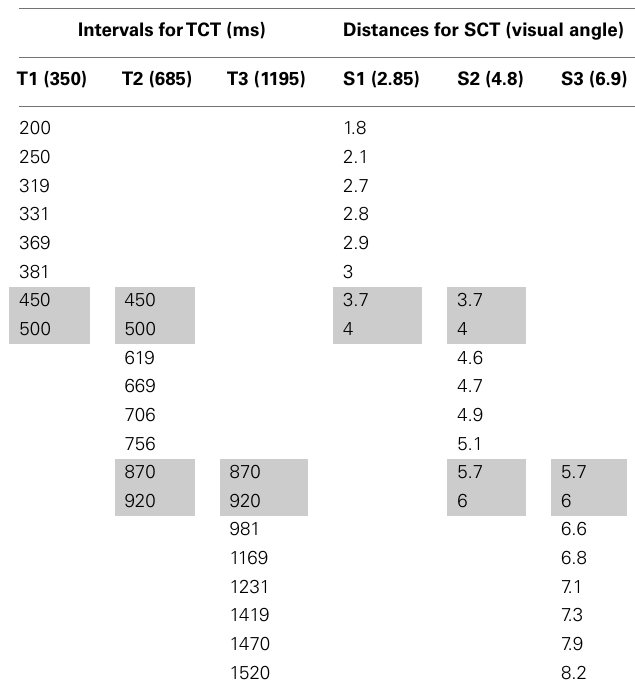
Table 1 |Time and distance values used inTCT and SCT in human